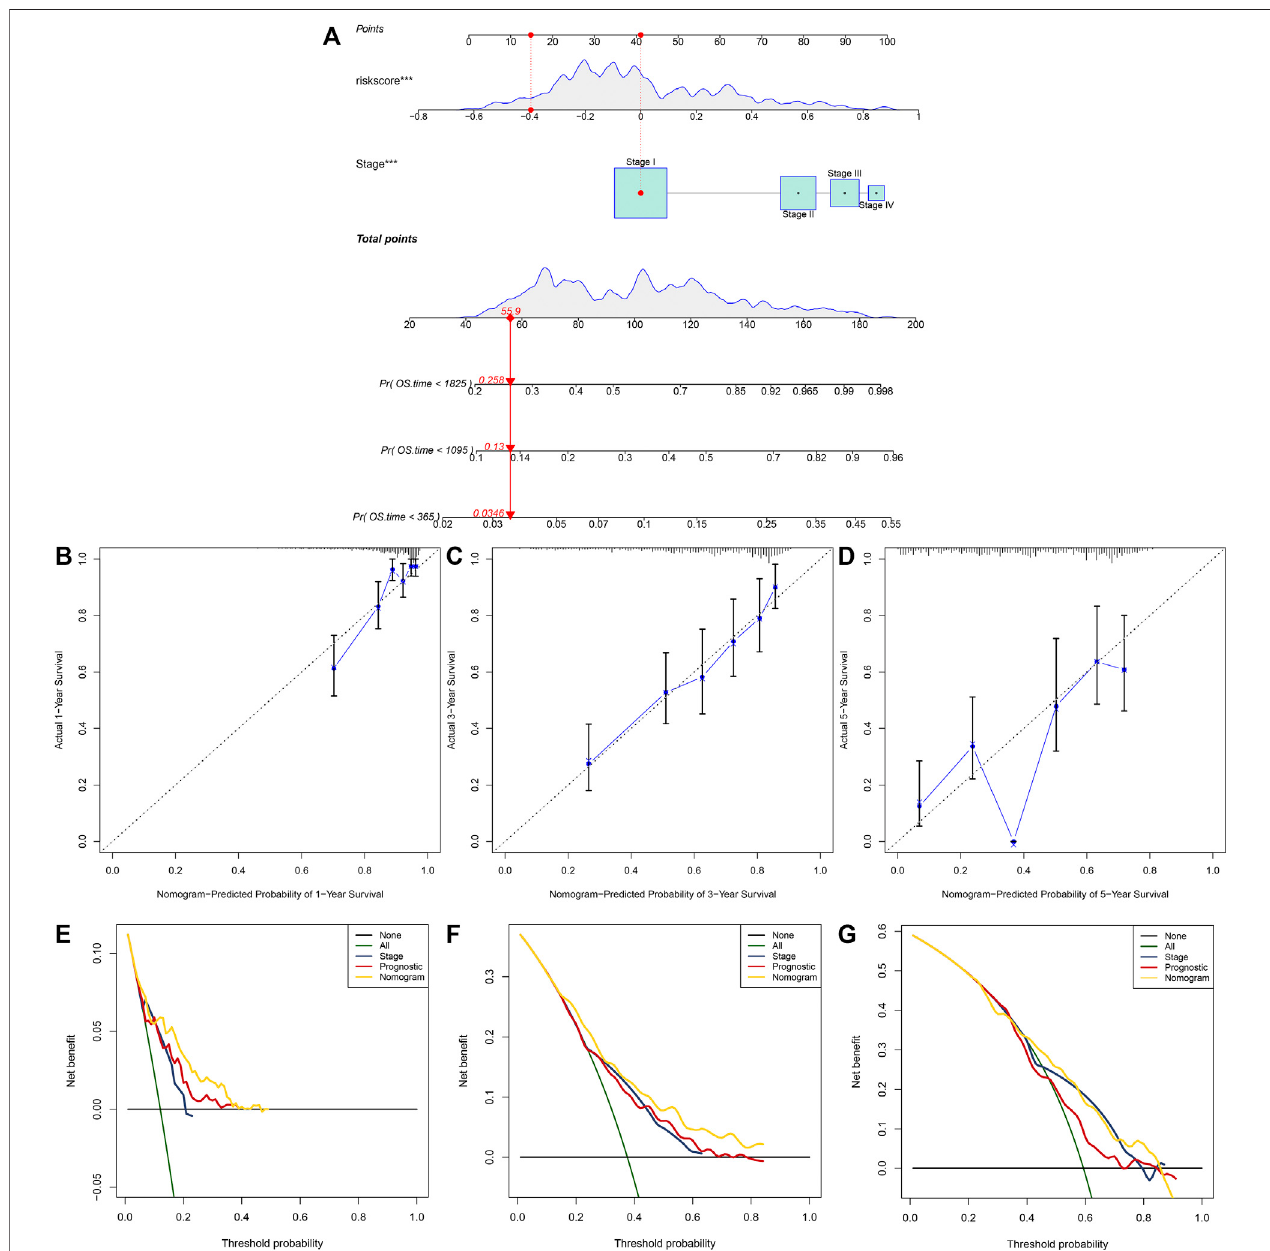
FIGURE 8| Establishment ofthe nomogram for predicting survival likelihood of LUAD patients in the TCGA dataset. (A) The nomogram that included independent prognostic indicators obtained from multivariate-cox regression analysis for predicting one, three and 5-year OS likelihood of LUAD patients. Each variable (m 6 A risk scoreandstage)wasprojectedtothepointscaleforobtainingavalue. (B – D) Calibrationplotsofthenomogram-predictedone,threeand5-yearOSprobabilitiesagainst the observed rates. The x -axis represented nomogram-predicted survival and the y -axis represented actual survival. (E – G) Decision curves for the clinical net bene fi t of each model in comparison to all or none strategies. The x -axis indicated the threshold probability, and the y -axis indicated the net clinical bene fi t.